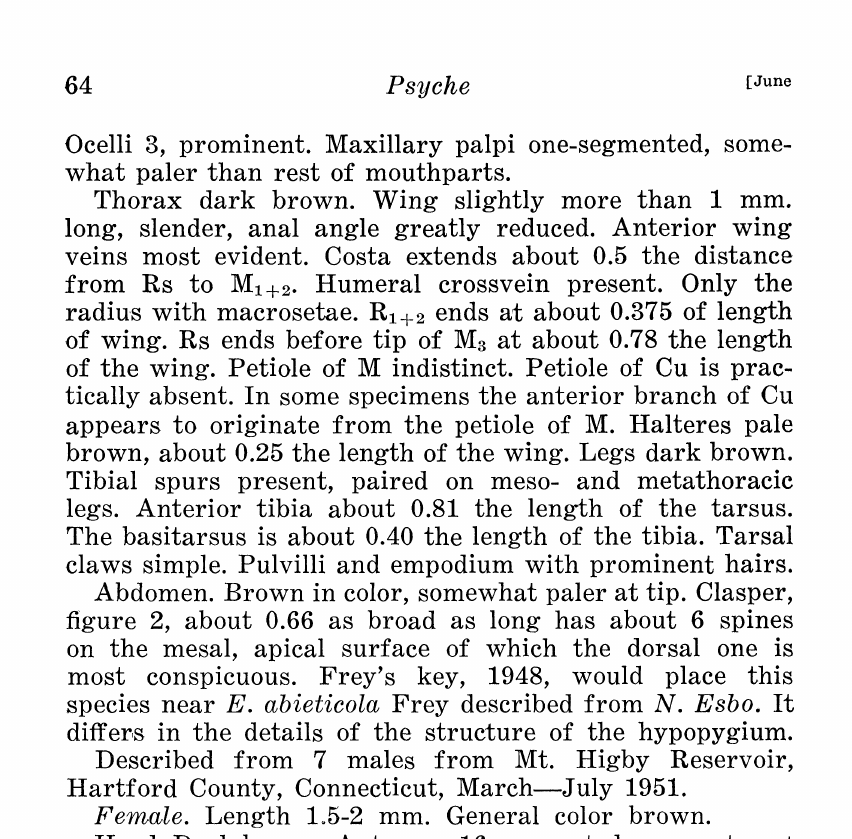
Fig. 1. Fifth flagellar segment of male Epidapus ohannseni. Fig. 2. Dorsal view of male hypopygium of Epidapus ohannseni. Fig. 3. Ven- tral view of male hypo,pygium of Zelmira williami. Fig. 4. Ventral view of male hypopygium of BracIysia beIlingeri. Fig. 5. Ventral view of male hypopygium of Braclysia